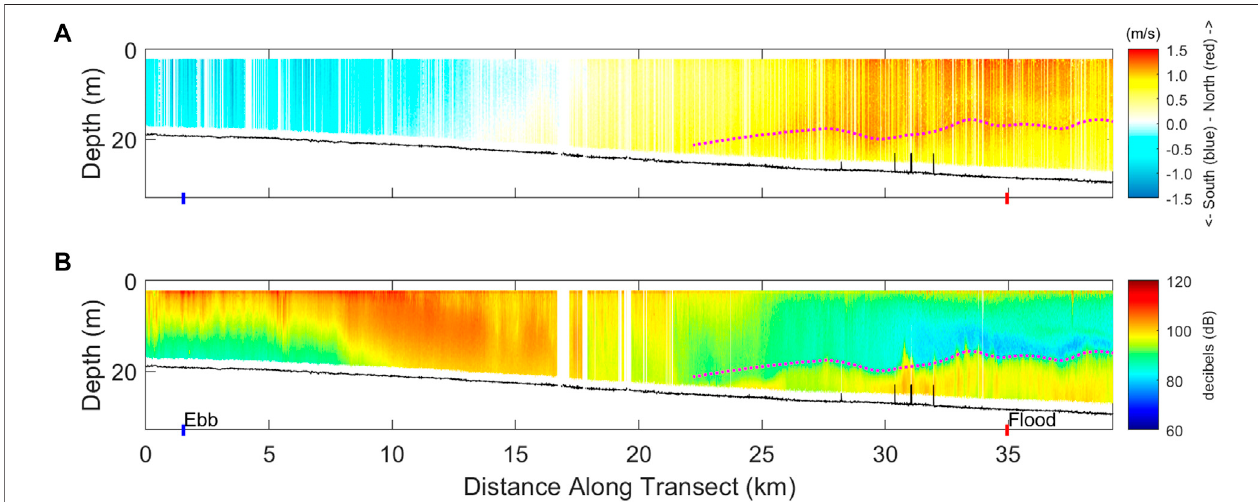
FIGURE 7 | Data observed along Transect #21. The distance traveled along the transect is shown on the horizontal axis, and water depth along the vertical axes. Depth inthewatercolumnwasestimatedafteraccountingfortheapproximatesubmergeddepthoftheADCPsensor.Theblacklinerepresents approximatelocationof the sea fl oor. (A) : water speed in direction of primary axis is displayed in the colorbar in m/s, which was 20.5 o clockwise from North. Blue colors indicate fl ow out of the Gulf, red indicates fl ow into the Gulf (B) : backscatter intensity (a measure of the return energy in decibels [dB]) in the colorbar. High values of backscatter intensity indicate the presence of suspended sediment. The data was fi ltered using the Winriver II software and then a triangular smoothing fi lter was applied. The white vertical bars in (A) representdata thatwasremoved because eitherthe GPSor bottom tracking wasdeemed unreliable. The blue and red tickmarksonthe x -axis represent the positionalongthetransectofebband fl ood,respectively,shownin Figure8 .Thedashed linesduring fl oodtide(~23 – 40 km)representtheapproximatethicknessofthe near-bed turbid layer, as described in Section 4.1 .